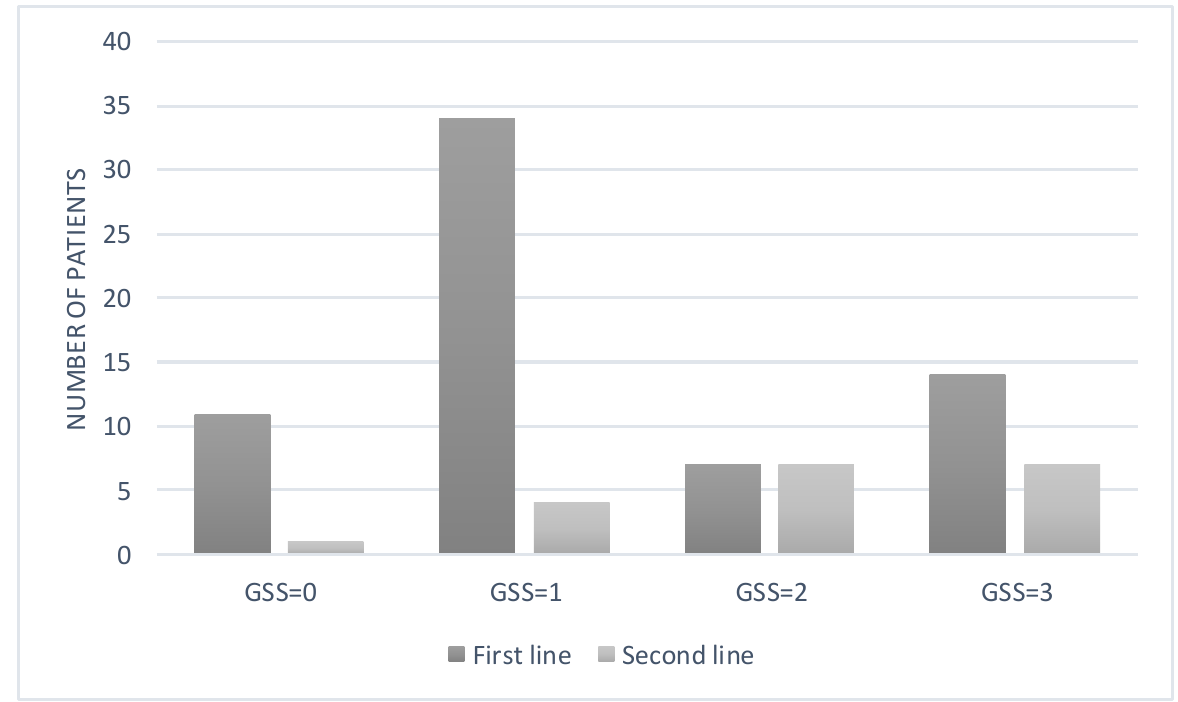
Figure 6. Genotypic susceptibility scores (GSSs) to the current first-line and second-line ART therapy of the patients.